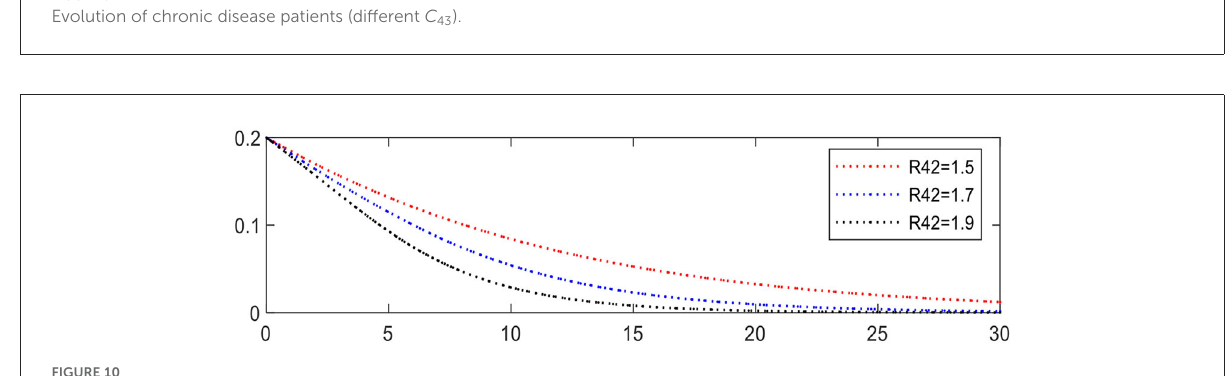
FIGURE10 Evolution of chronic disease patients (different R 42